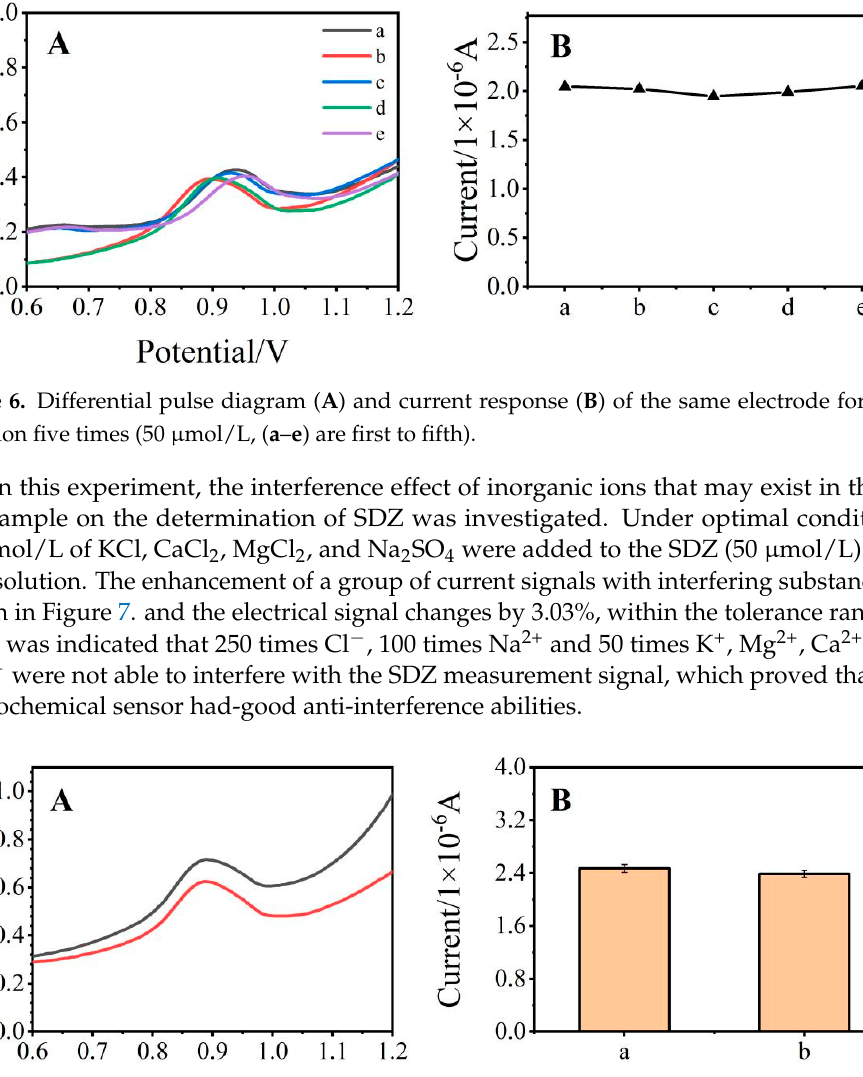
Figure 7. Differential pulse curve ( A ) and current response ( B ) of acetic acid − sodium acetate buffer solution containing 50 μ mol/L of SDZ detected by the same electrode under the same conditions (( a ), interfering substances added; and ( b ), without interfering substances added).